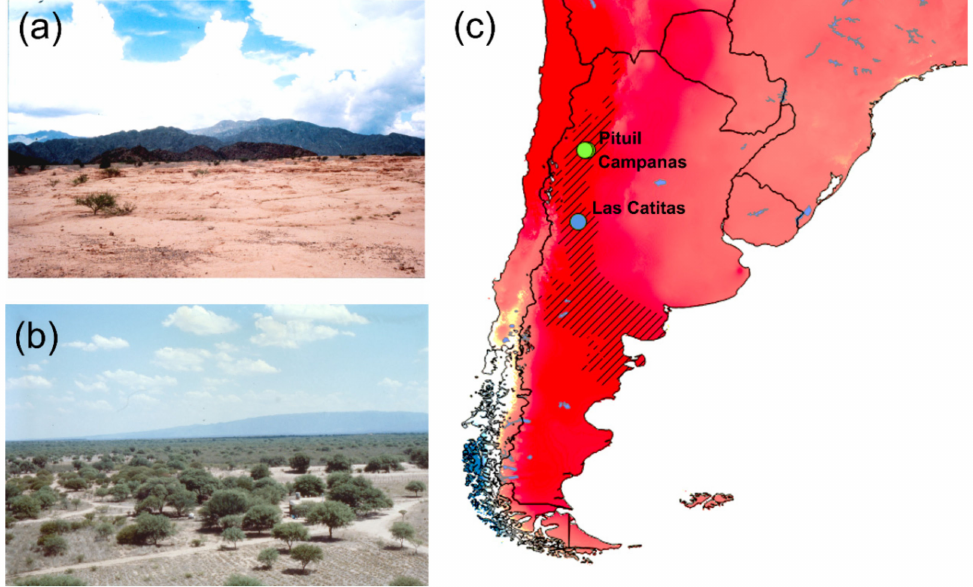
Figure 1. The material collection area: ( a , b ) Photos of the landscape features in the La Rojas province, where Pituil and Campanas are located. ( c ) Aridity map, the Monte biogeographical province (NW Argentina) marked by black diagonal lines [4,5,10,11]. The collection localities are marked by blue (Mendoza province, A. cavifrons ), and green (Las Royas province, A. heteroclyta ) dots. The Global Aridity Index dataset freely available at CGIAC Consortium for Spatial Information web page (http: // csi.cgiar.org / Aridity / ) was used to build the map. The aridity degree is shown, where the dark red areas are the